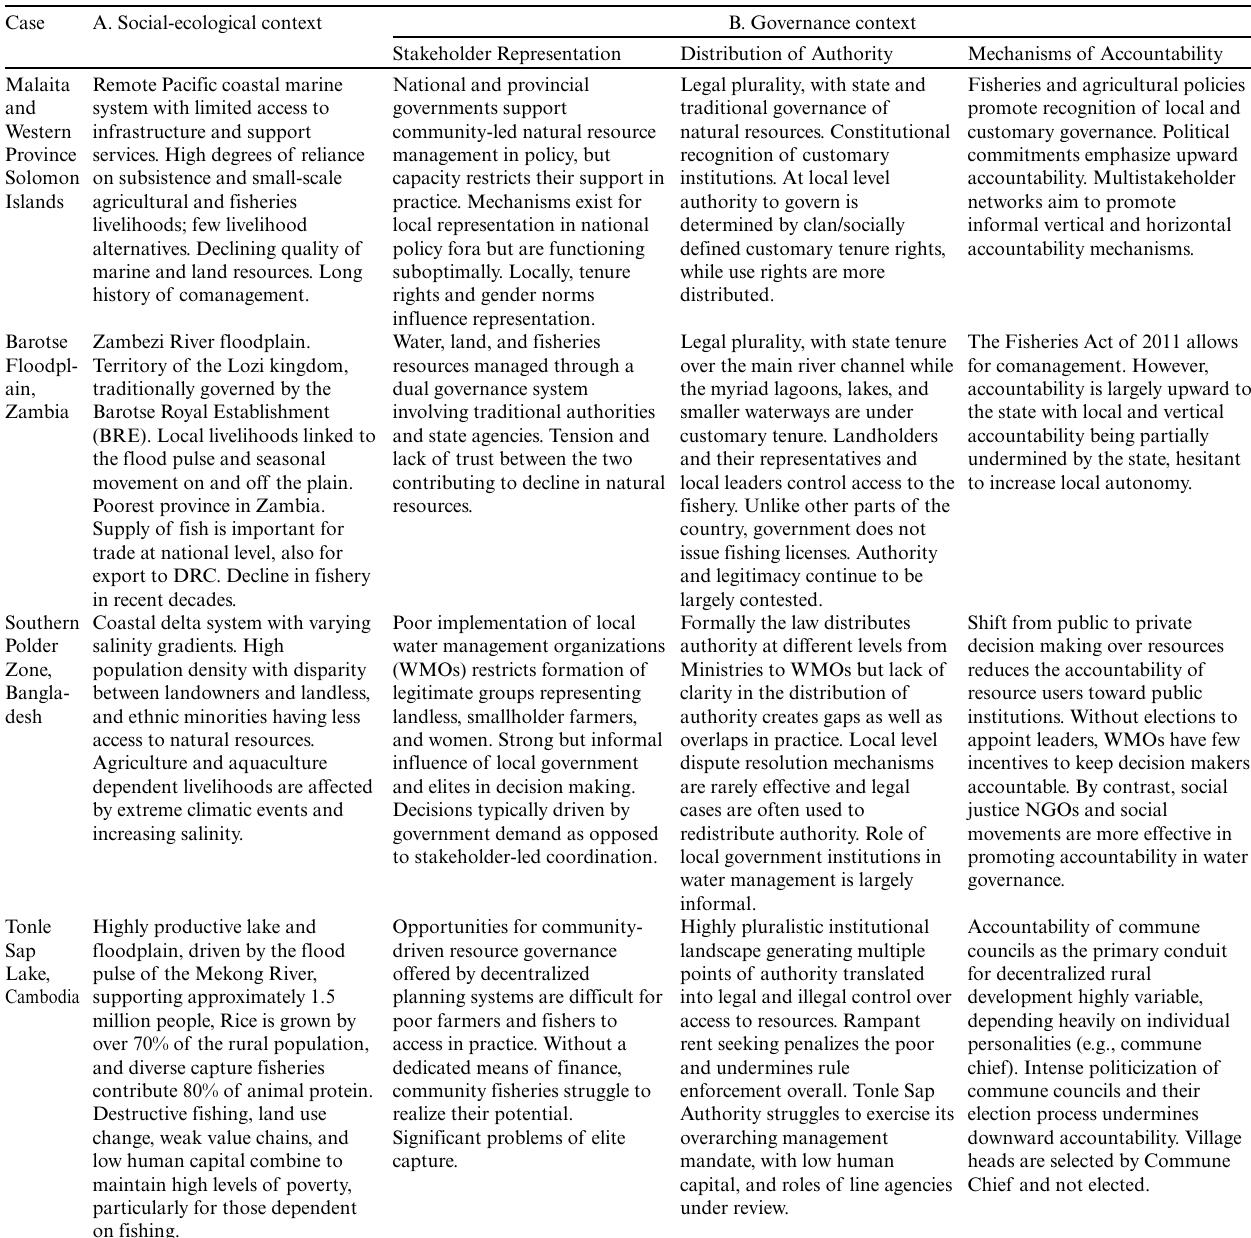
Table 1 . (A) The social-ecological system of focus in each case study site. (B) The governance context and the emerging or preparatory signs of